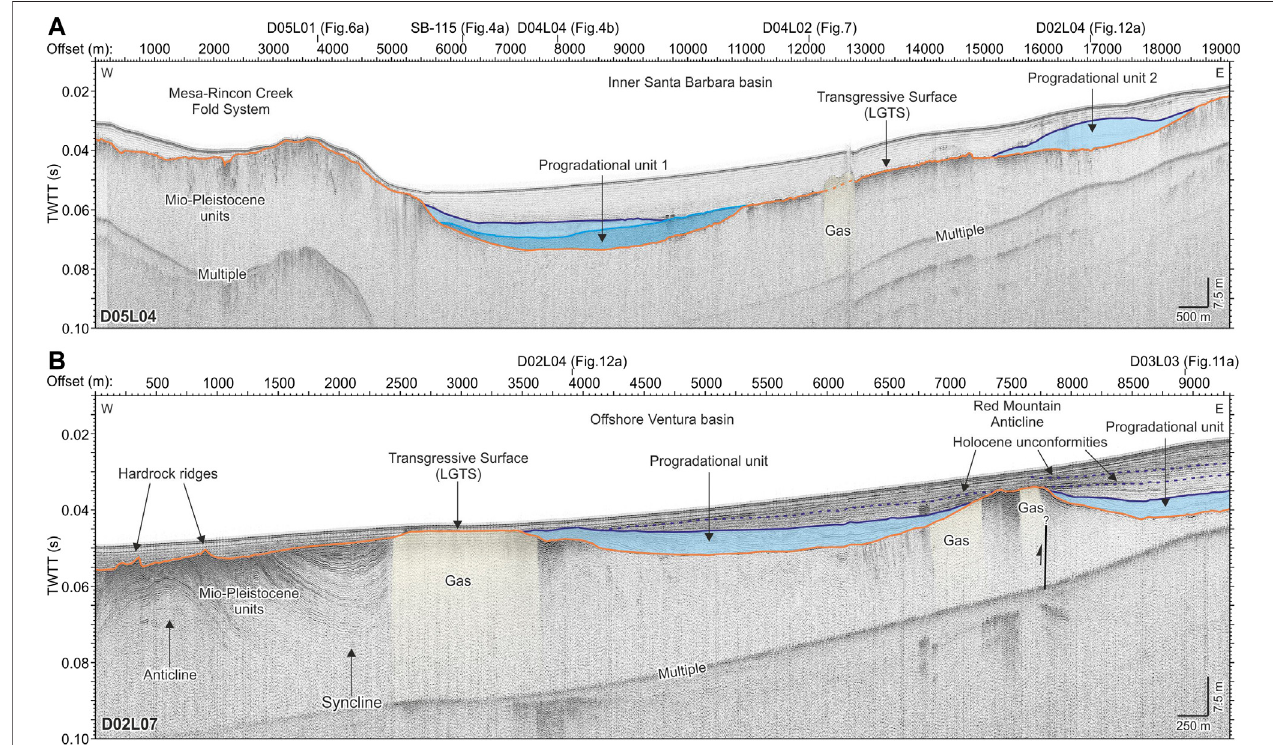
FIGURE 5 | Interpreted CHIRP strike pro fi les D05L04 (A) and D02L07 (B) showing the Last Glacial transgressive surface (LGTS; continuous orange line) separating the folded Pleistocene units below from the overlying Holocene units. The light blue units bounded by blue lines correspond to different progradational units identi fi ed in the area. Note that a number of Holocene unconformities are observed and may be related to the uplift produced by the offshore Red Mountain anticline.Thehorizontalscaleisshownonbothpro fi lesastheyaredifferentandtheirlocationsareshownin Figures2 , 3 .Uninterpretedpro fi lesareprovidedin Supplementary Figure S5